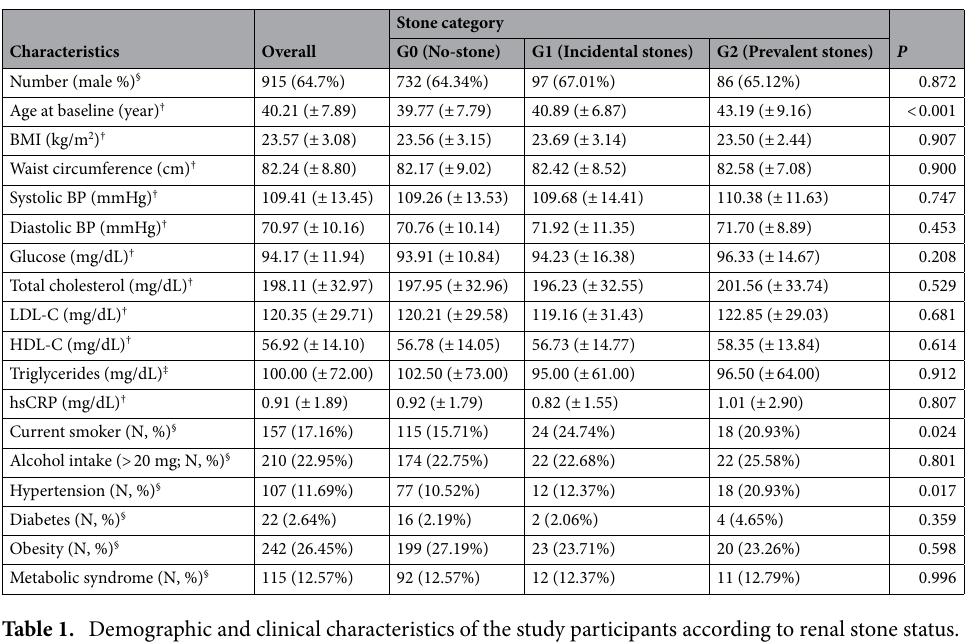
Table 1. Demographic and clinical characteristics of the study participants according to renal stone status. BMI, body mass index; BP, blood pressure; LDL-C, low-density lipoprotein cholesterol; HDL-C, high-density lipoprotein cholesterol; and hsCRP, high-sensitivity C-reactive protein. Participants were compared according to renal stone status, using an analysis of variance (ANOVA) for continuous variables or a χ 2 test for categorical variables. † Mean (SD). ‡ Median (interquartile range). § ≥ 20 g of ethanol per day.